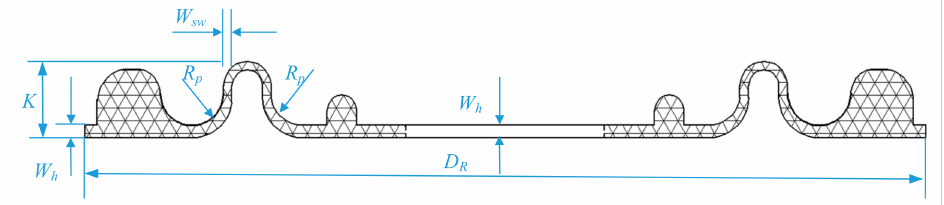
Figure 3. Structural parameters of beryllium bronze reed (BBR).